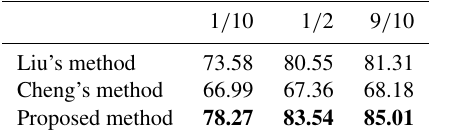
Table 5. The overall classification accuracy (%) on the whole-sky dataset. 1 / 10, 1 / 2 and 9 / 10 are the certain proportions of the train- ing set selected randomly from each category, and the rest corre- spondingly forms the testing set. The best results are labelled in bold font.